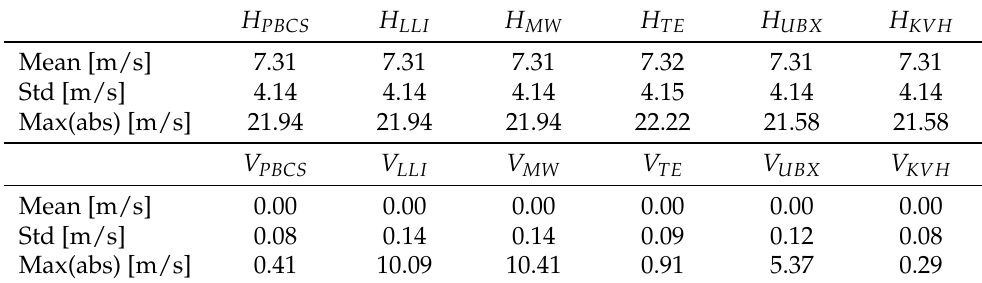
Table 4. Horizontal and vertical velocity statistics—Case Study